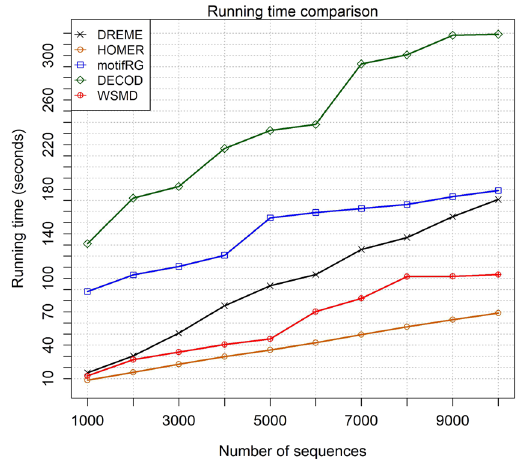
Figure 4. Comparison of running time (seconds) for DREME, HOMER, motifRG, DECOD and